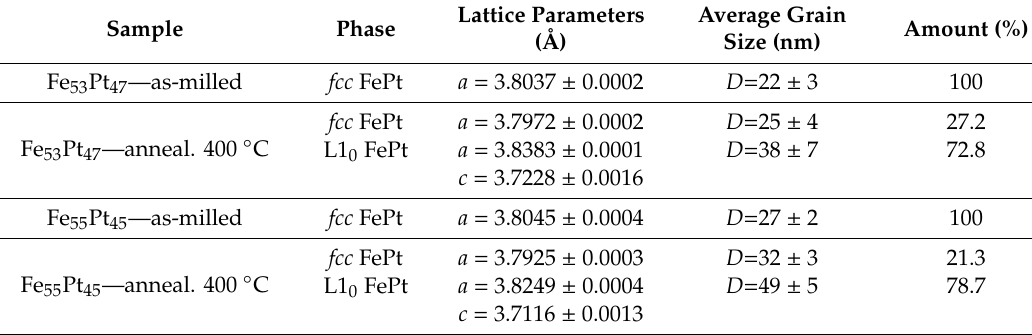
Figure 3. MAUD full-profile fitting of the di ff ractogram of sample Fe 53 Pt 47 annealed at 400 ◦ C. Table 1. Lattice parameters and average grain sizes obtained from full-profile MAUD analysis.